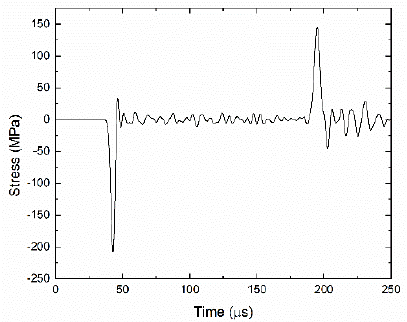
Fig. 2. The stress pulse propagation from the left to right in the incident bar. The location of the stress pulse is annotated by the arrow in each figure and the interframe time is 24.8µs.